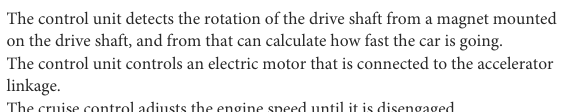
TABLE 6 An example of propositional coding using the ShadowBox Lite Task. Expert’s